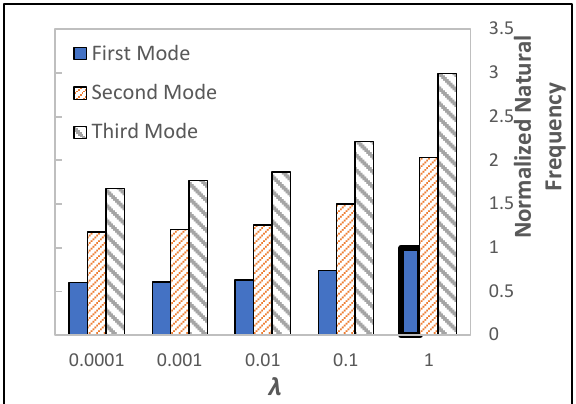
Figure 9. Natural frequencies of the first three modes of vibration of the architected plate. All frequencies are normalized to the first natural frequency of the plate with λ = 1 (the bar with a thick borderline on the chart).